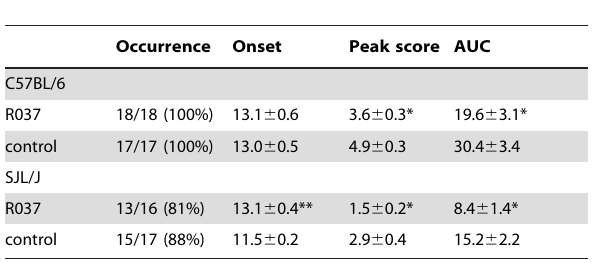
Table 1. Clinical scores and occurrence.